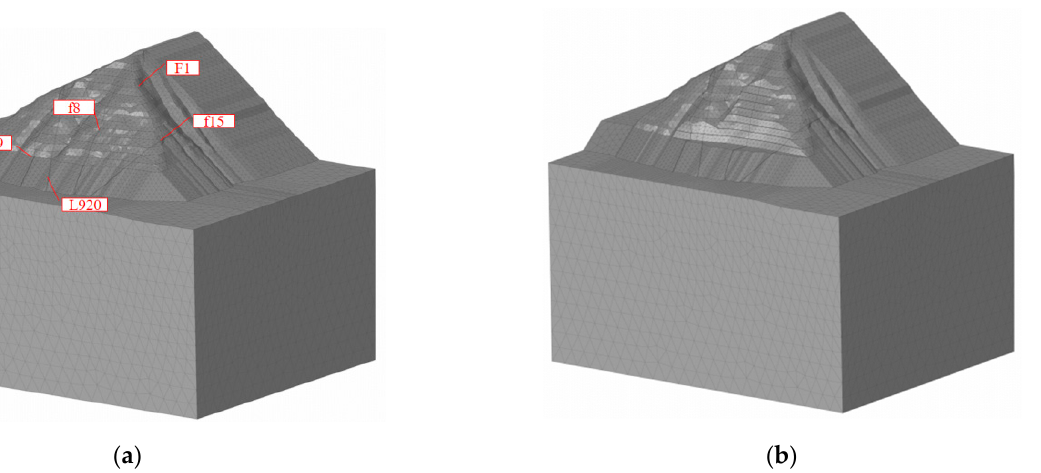
Figure 9. Three-dimensional numerical model of the left bank slope. ( a ) before excavation. ( b ) after excavation.